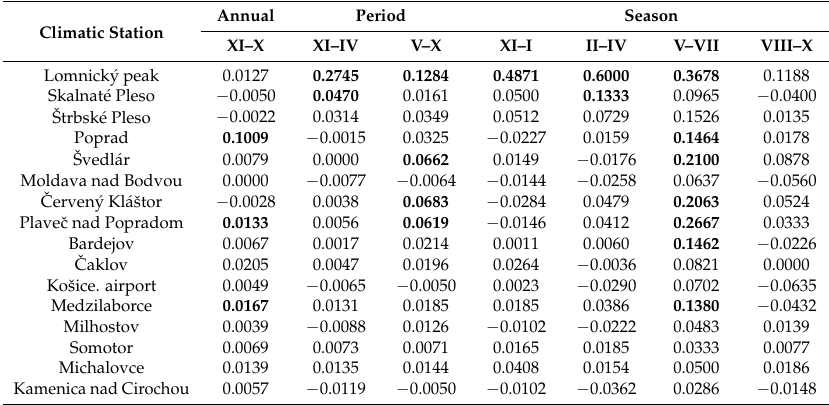
Table 2. Annual and seasonal precipitation trends in climatic stations.